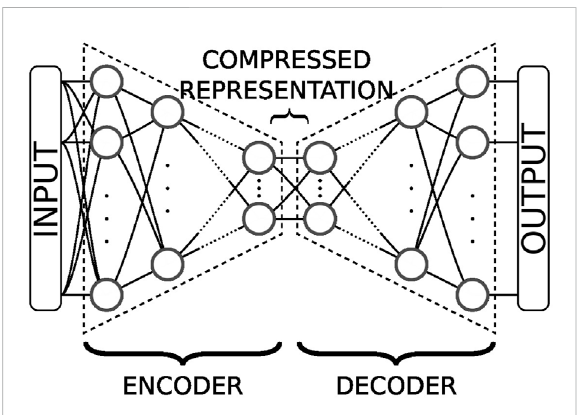
FIGURE 5 An autoencoder is the association of two blocks. The fi rst one, on the left, compresses the input data into a lower- dimensional representation, or code, in the latent space. The second one, on the right, decompresses the code back into the original